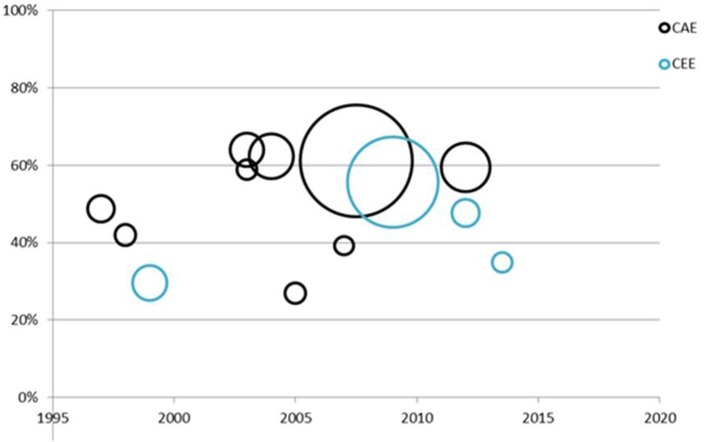
Time trend of the frequency of parents citing 38°C as the threshold for the definition of fever in children. CAE, countries with advanced economies; CEE, countries with emerging and developing economies. Each point represents one study; dot size is proportional to inverse of the variance and thus the study weight in the regression.